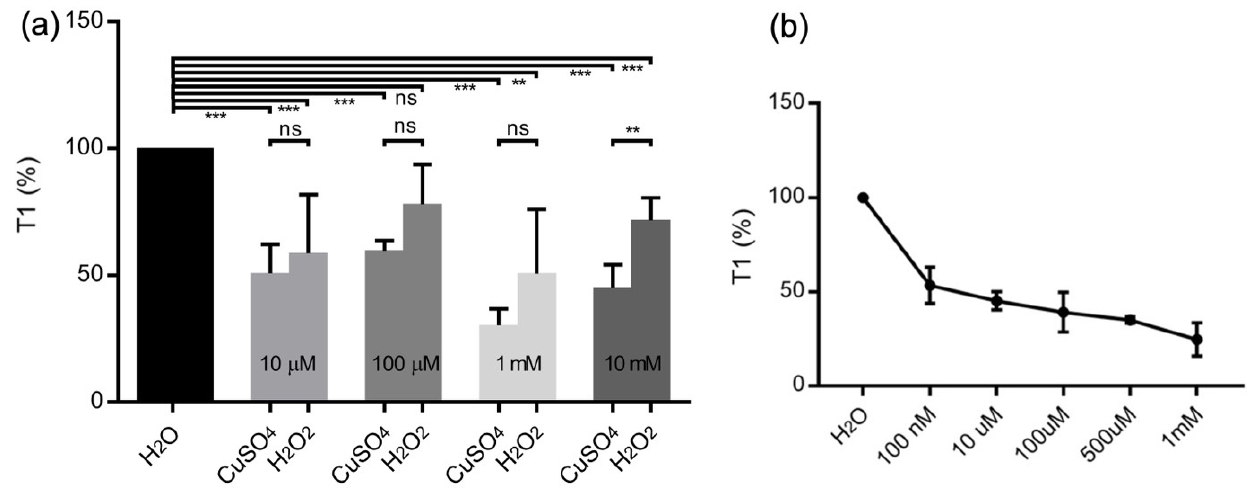
Figure 3. ( a ) T1—relaxation measurements of water, CuSO 4 and after addition of H 2 O 2 at different concentrations. Each bar represents an average of 4–5 independent measurements. ( b ) T1—relaxation measurements of CuSO 4 at different concentrations ( n = 4). The error bars represent standard deviations. (ns = non significant, * p ≤ 0.05, ** p ≤ 0.01, *** p ≤ 0.001, **** p ≤ 0.0001).